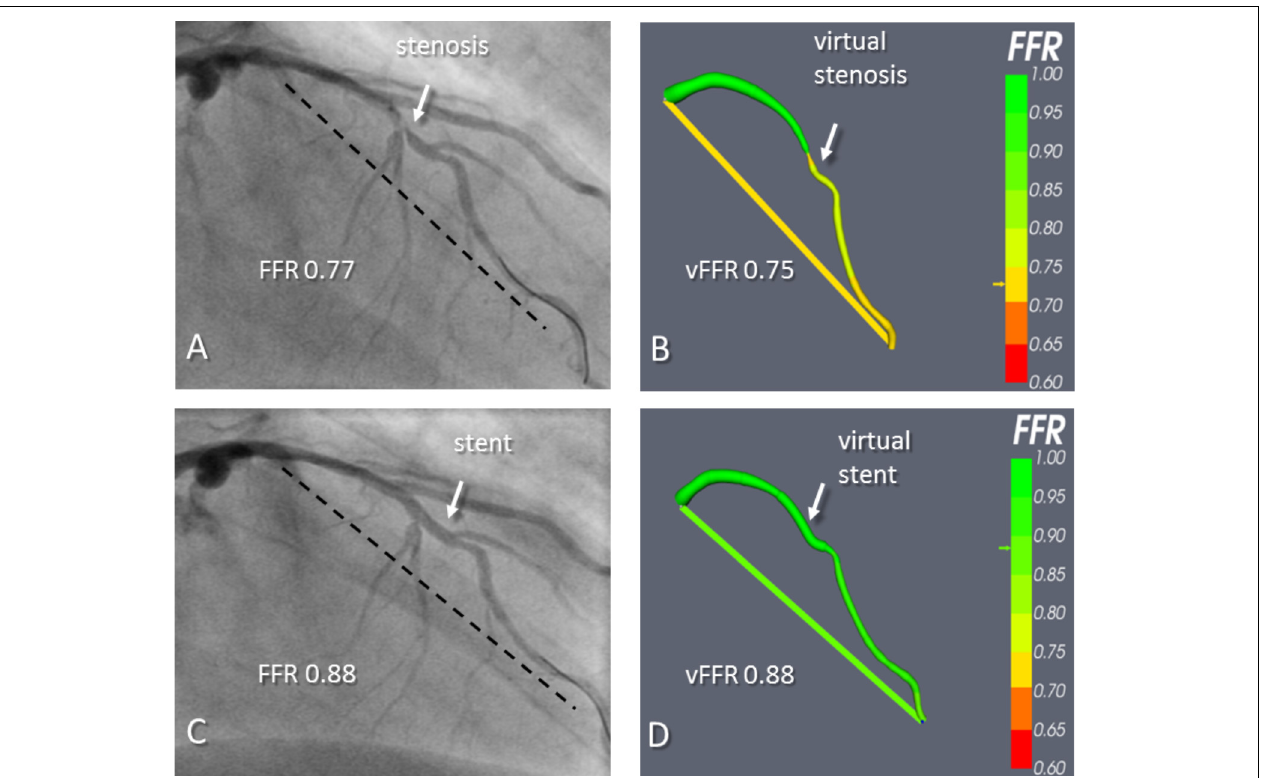
FIGURE 2 | An example of virtual coronary intervention. Angiography revealed a severe mid vessel stenosis in the LAD (arrow). The mFFR between the proximal and distal points marked with the dashed line was 0.77. (B) The angiograms were used to model the vFFR using the VIRTUheart system, which was calculated to be 0.75 over the same segment. This is displayed as a straight yellow line connecting the same two points between which the vFFR was calculated, exactly matching the two spots marked by the dashed line in (A) . (C) After implantation of a 2.75 mm × 18 mm stent at the stenosis, the mFFR was 0.88 over the same segment. (D) VCI using the VIRTUheart system was then used to implant a “virtual” 2.75 mm × 18 mm stent, and the recalculated vFFR was 0.88, corresponding to a green color in the line connecting the two points. Reproduced from JACC: Cardiovascular imaging under creative commons license CC BY 4.0 (Gosling et al.,